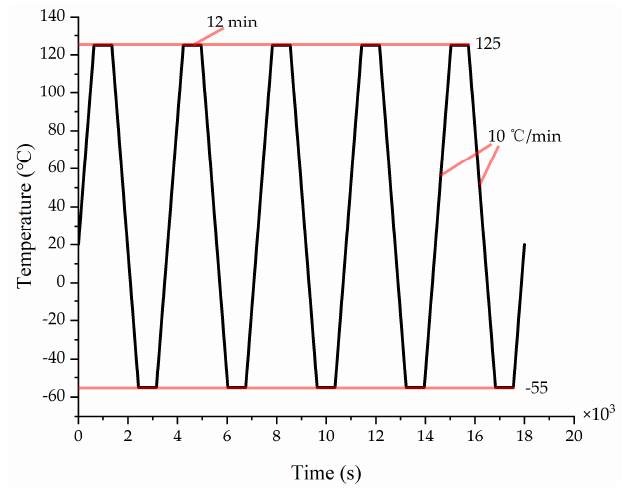
Figure 2. Temperature cycling profile.